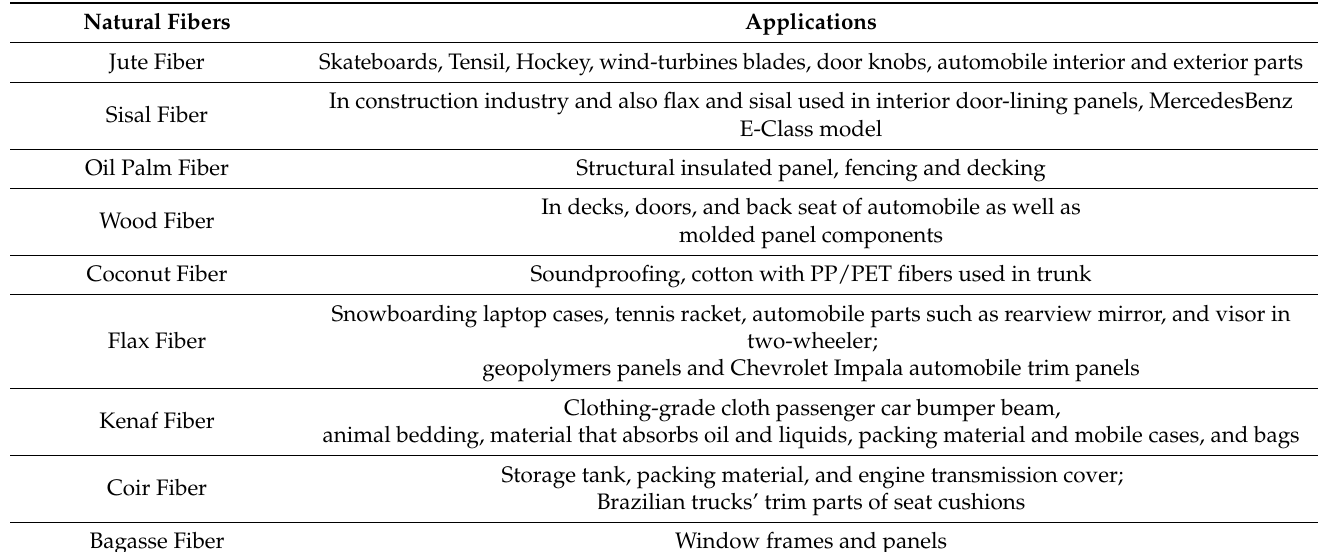
Table 5. Applications of different natural fibres